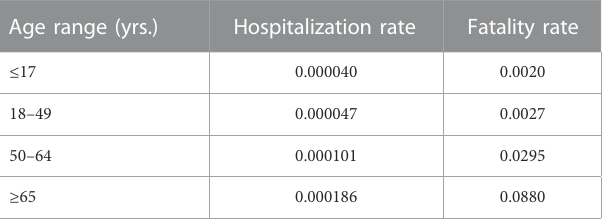
TABLE1Hospitalizationandfatality percapita ratesperworkeragecategories. Age range